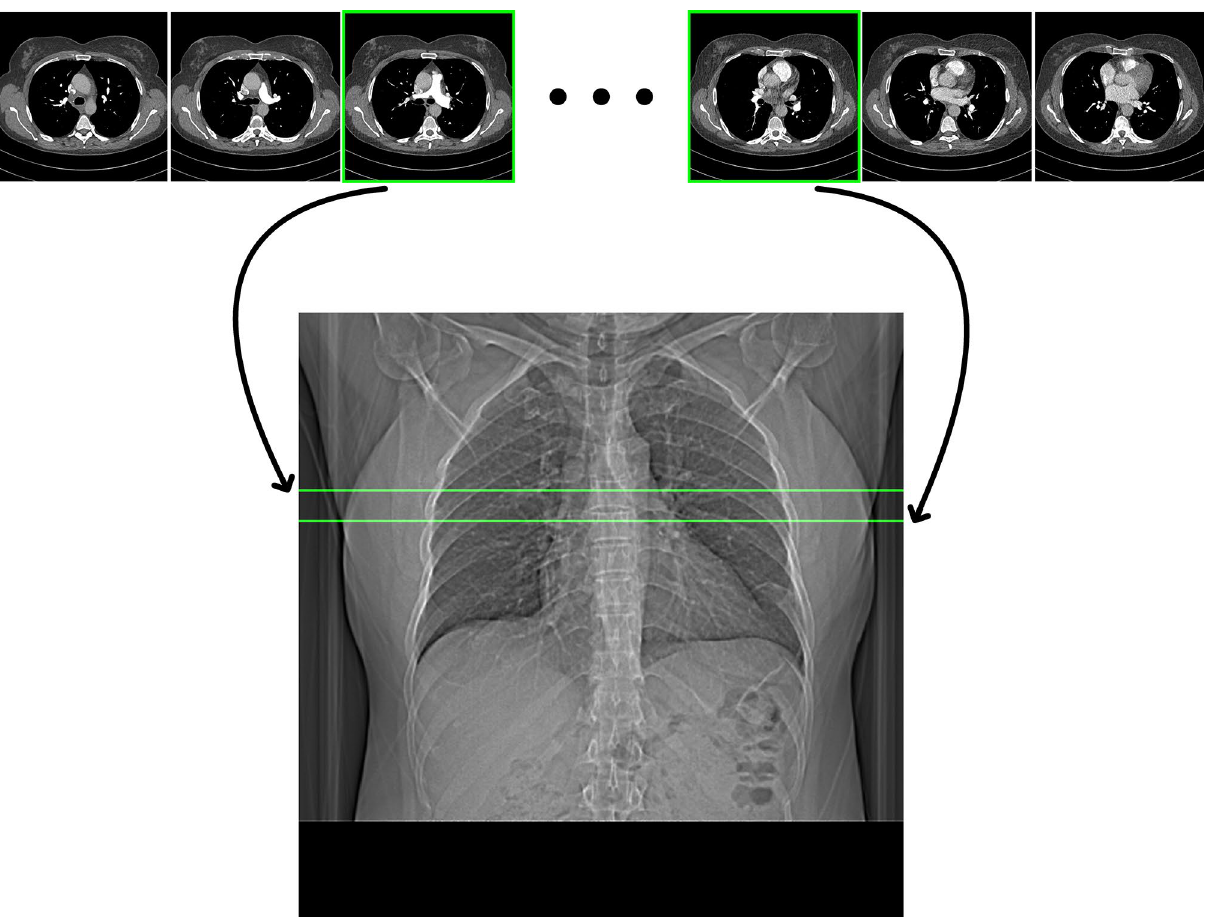
Figure 2. The axial slices of the CT scan between the cranial and caudal boundary of the pulmonary trunk were used to single out the 2D region in the CT scout view corresponding to the area of the pulmonary trunk (green). Images were cropped for better